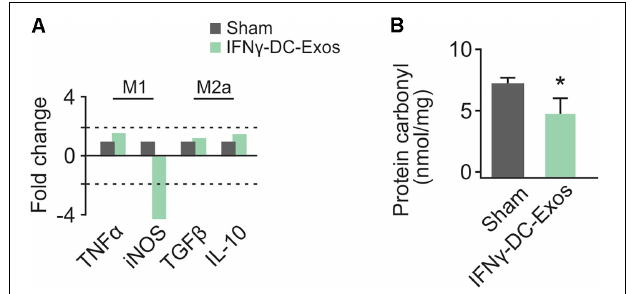
FIGURE 1 | IFN γ -DC-Exosomes increase spreading depression threshold in vitro and in vivo. (A) When applied to naïve hippocampal slice cultures, IFN γ -stimulated dendritic cell exosomes (IFN γ -DC-Exos) significantly ( ∗ p ≤ 0.001) increased spreading depression threshold three days later, compared to untreated control slices. (B) Nasally administering IFN γ -DC-Exos to rats likewise significantly ( ∗ p ≤ 0.001) increased the threshold to neocortical spreading depression one day later when compared to untreated sham animals, or animals nasally administered unstimulated dendritic cell exosomes (Unstim-DC-Exos). Significance determined by ANOVA plus post hoc Holm-Sidak testing.